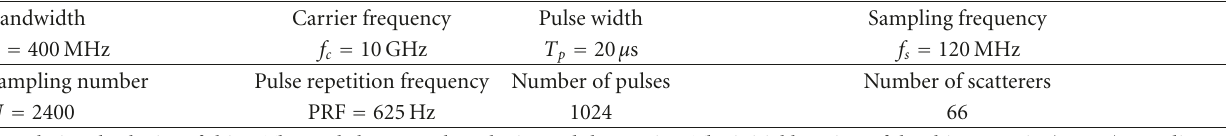
Table 3: Parameters for the simulated